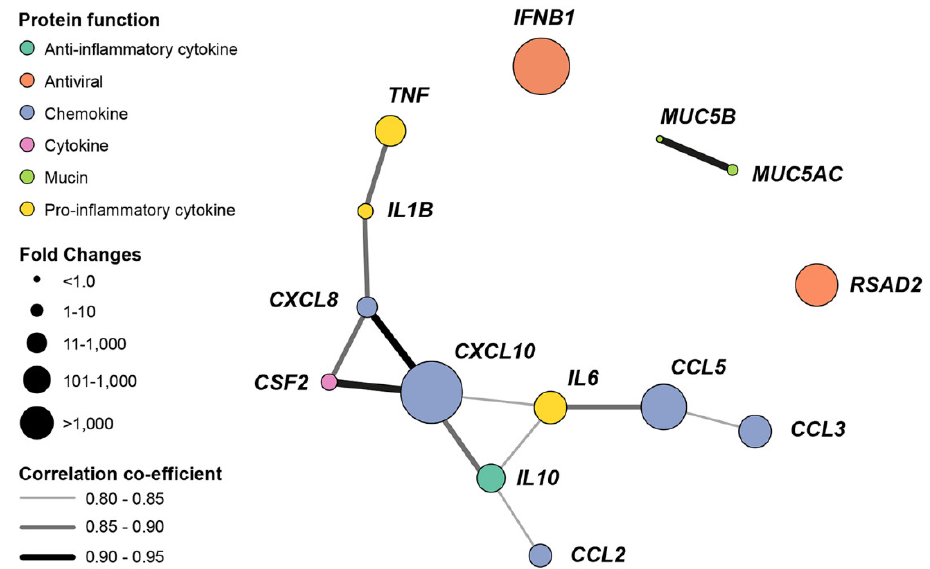
Figure 6. Pandemic IAV H1N1pdm09 upregulates the expression of cytokine, chemokine and antiviral genes in wdNHBE cells. The gene coexpression network depicts nodes representing the assayed genes, node size represents the magnitude of fold-change and edges (lines linking nodes) indicate the strength of the coexpression as quantified by the Pearson Correlation Coefficient. The threshold for visualizing coexpression was set at 0.80. Gene naming follows the HUGO Gene Nomenclature Committee (HGNC) [100].